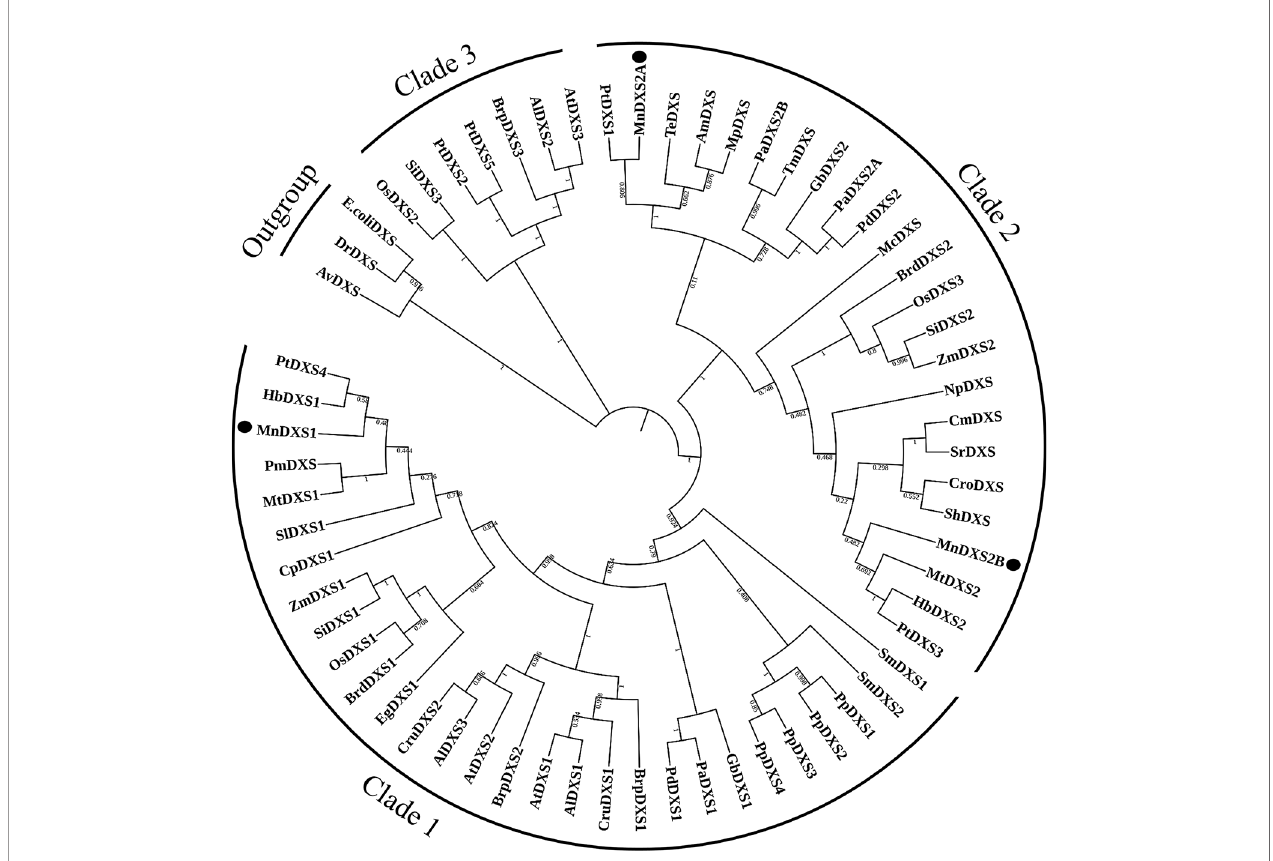
FIGURE 2 | Phylogenetic relationships among DXS proteins. The National Center for Biotechnology Information (NCBI) accession numbers of the amino acid sequences included in the phylogenetic tree are listed in Table S2